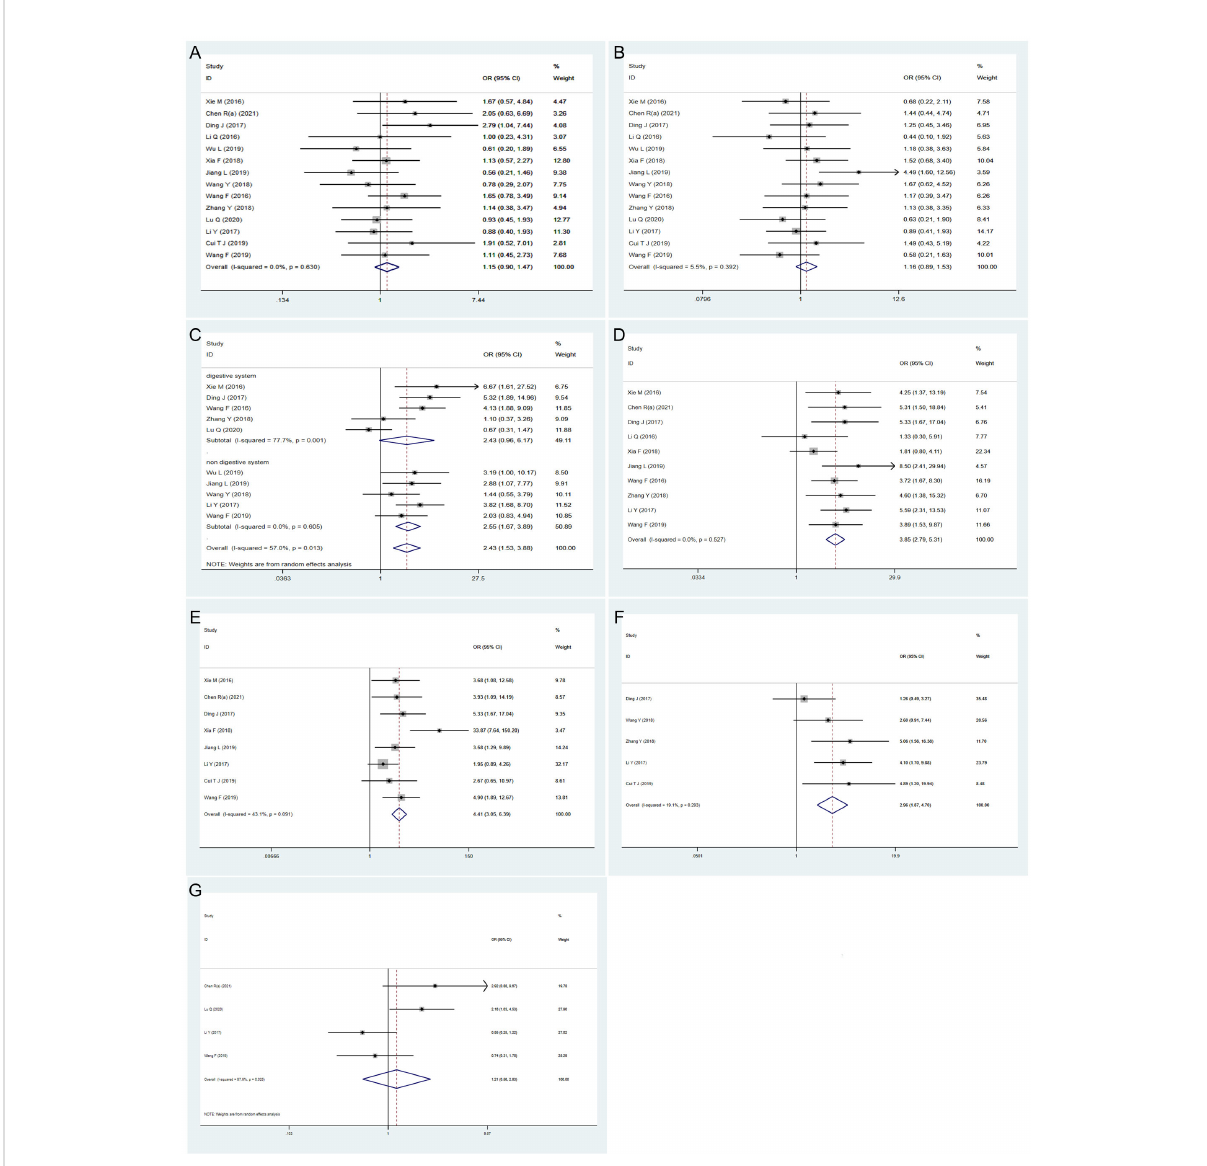
FIGURE 3 Forest plots showing the correlation between HOXA-AS2 expression and clinicopathological parameters. (A) age. (B) gender. (C) tumor size. (D) TNM stage. (E) lymph node metastasis. (F) distant metastasis. (G)